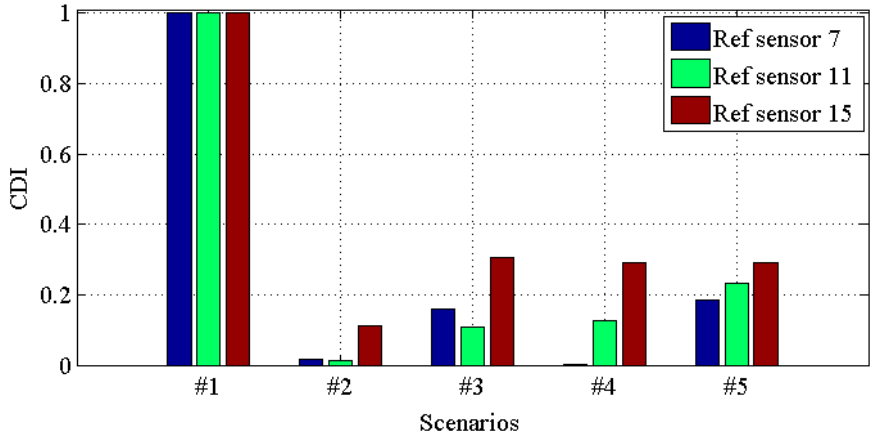
Figure 12. CDI for transmissibilities T(3, :), T(7, :), T(11, :) and T(15, :) with reference sensor 7, 11 and